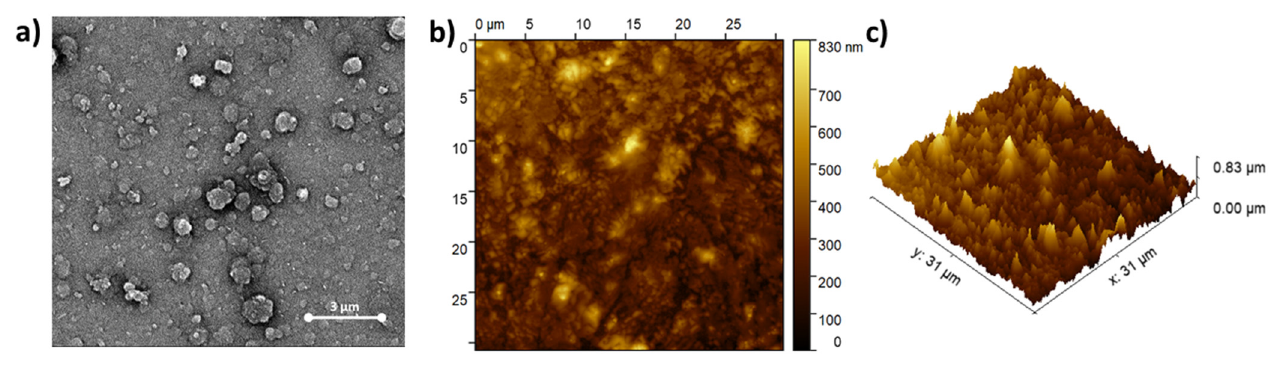
Figure 2. ( a ) SEM and ( b , c ) AFM images of (ZnPcNH 2 ) layer electrodeposited on ITO.